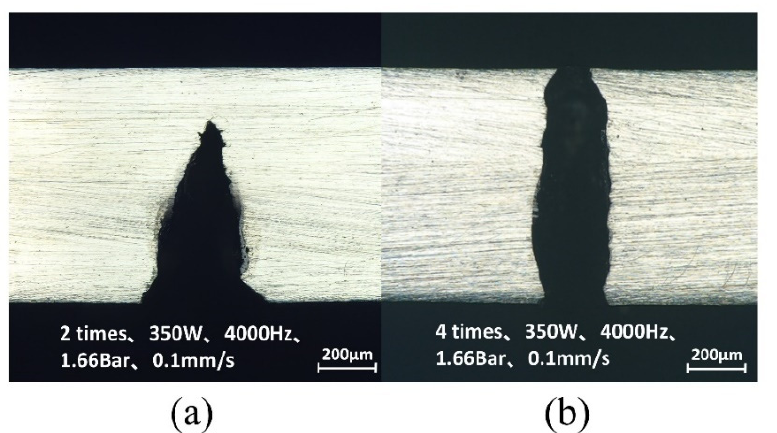
Figure 19. Comparison between WJGL and LBM.